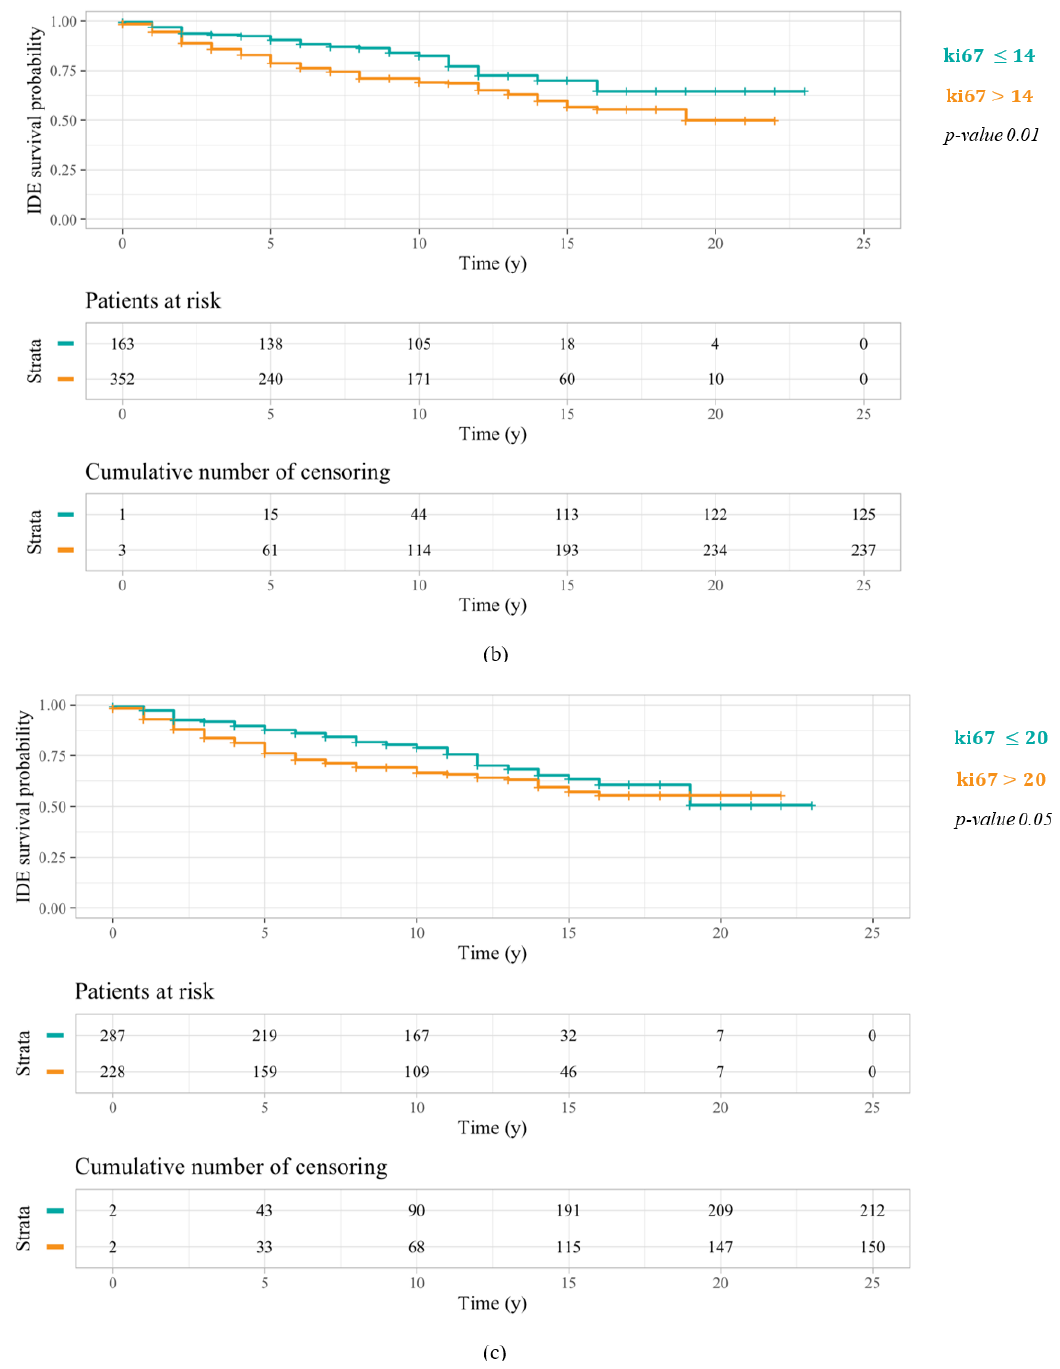
Figure 2. IDEFS curves related to a Kaplan – Meier analysis performed on patients over 50 years old with respect to the three different ki67 threshold values: 10% ( a ), 14% ( b ), and 20% ( c ). The log-rank test p -values highlighted a greater significance of the first cut-off.